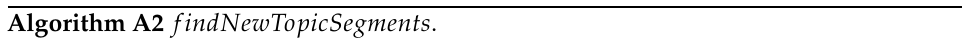
Algorithm A2 f indNewTopicSegments